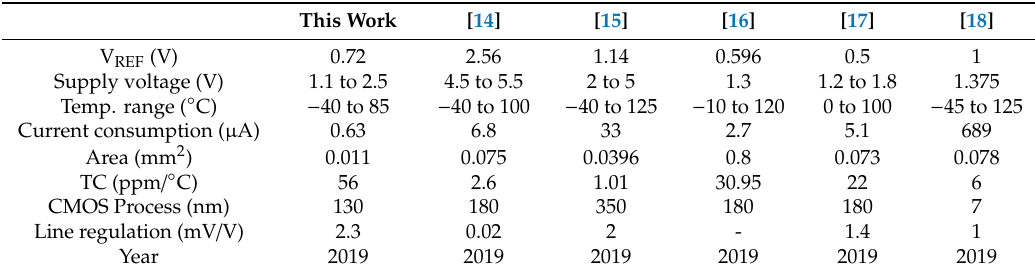
Table 9. Comparison with state-of-the-art